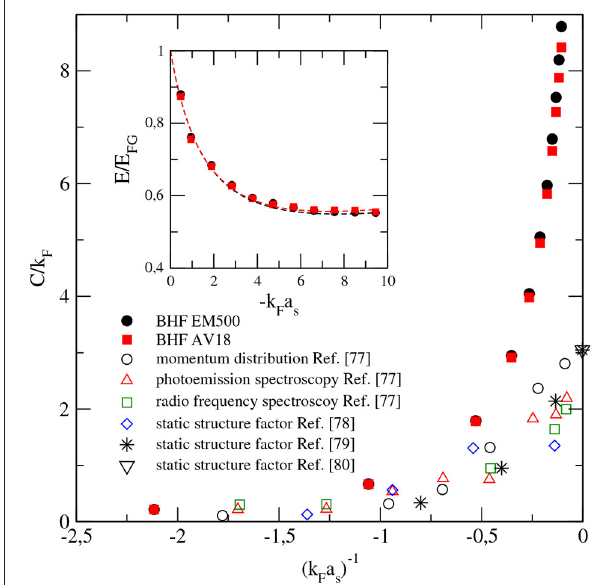
FIGURE 2 | Tan contact parameter as a function of ( k F a s ) − 1 in units of the Fermi momentum. Results for neutron matter from our BHF calculation obtained with the EM500 interaction (full circles) and the AV18 potential (full squares) are compared with data from experiments with ultra-cold fermionic gases of 40 K (open circles, triangles, and squares) [ 74] and 6 Li (open diamonds, stars and open down triangle) [75–77]. The inset shows the fit of our BHF results for the ground state energy of neutron matter with the Lacroix’s functional of Equation (4) (dashed